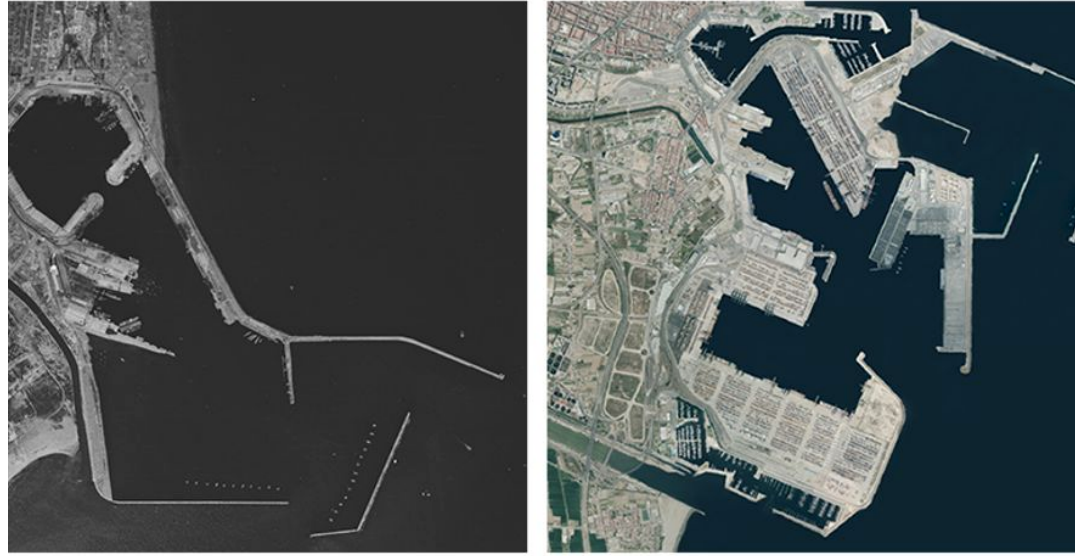
Figure 1. València’s harbour in 1947 and 2018. In the right picture we can see LMdV on the upper side. Source: Courtesy of Institut Cartogràfic